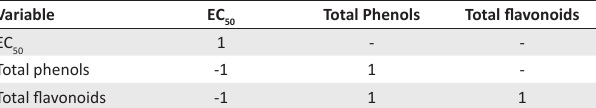
, total phenols and total 50